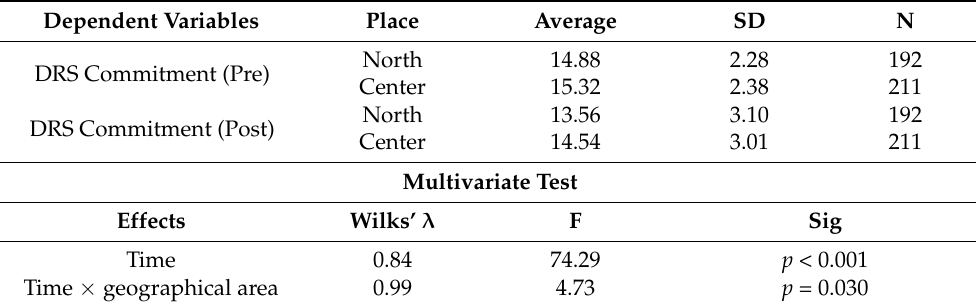
Table 15. Repeated measures ANOVA model of time (i.e., pre- and post-pandemic first-wave effect) and geographical area effects on commitment hardiness.